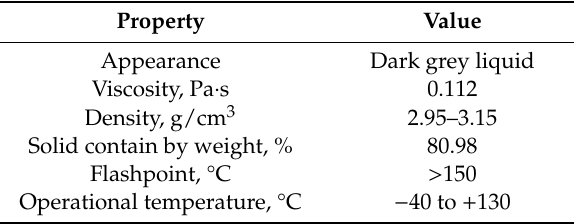
Table 1. Specification of MRF-132DG.